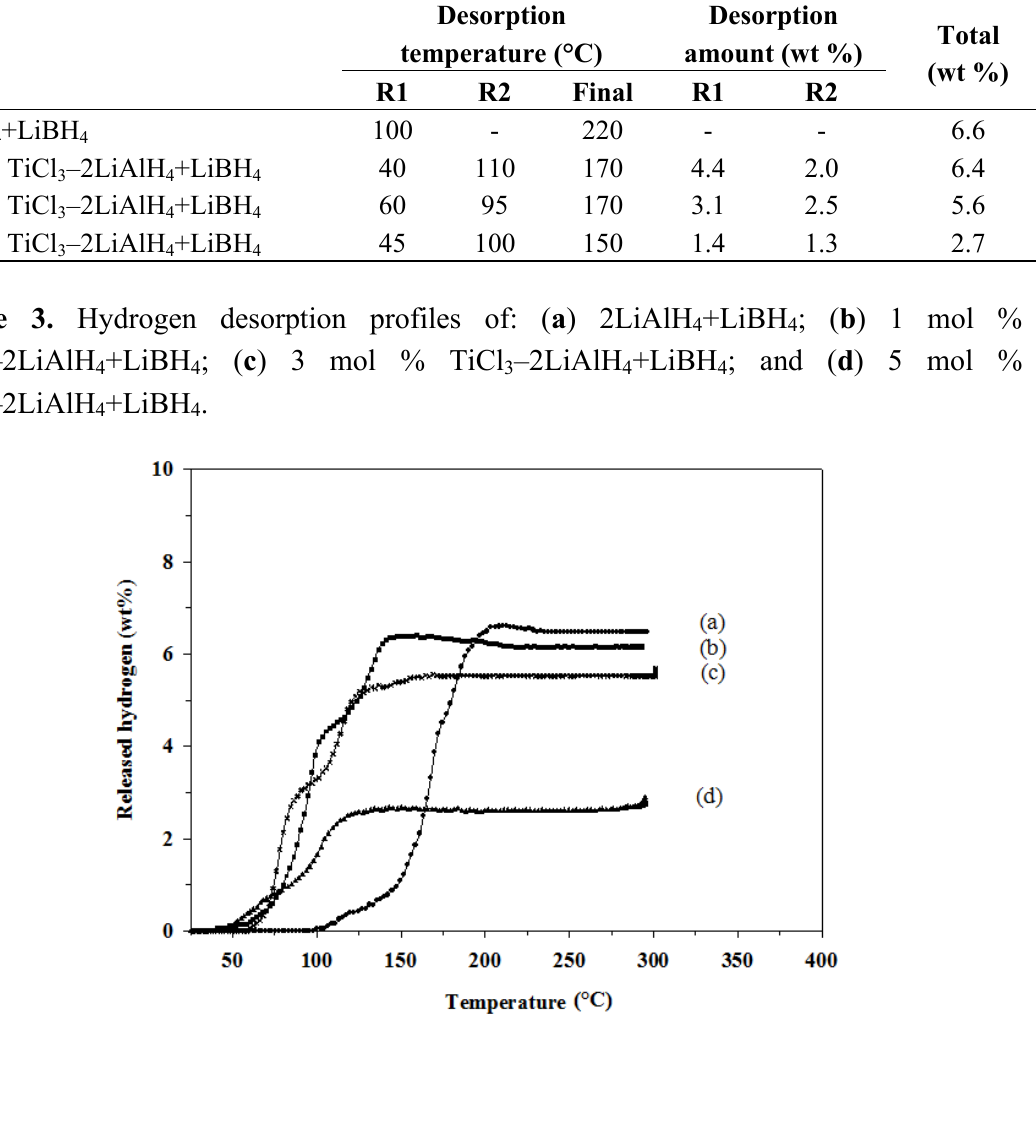
Table 3. Hydrogen desorption temperature and amounts of desorbed hydrogen of TiCl -doped 2LiAlH +LiBH in the first (R1) and second (R2) steps. 3 4 4